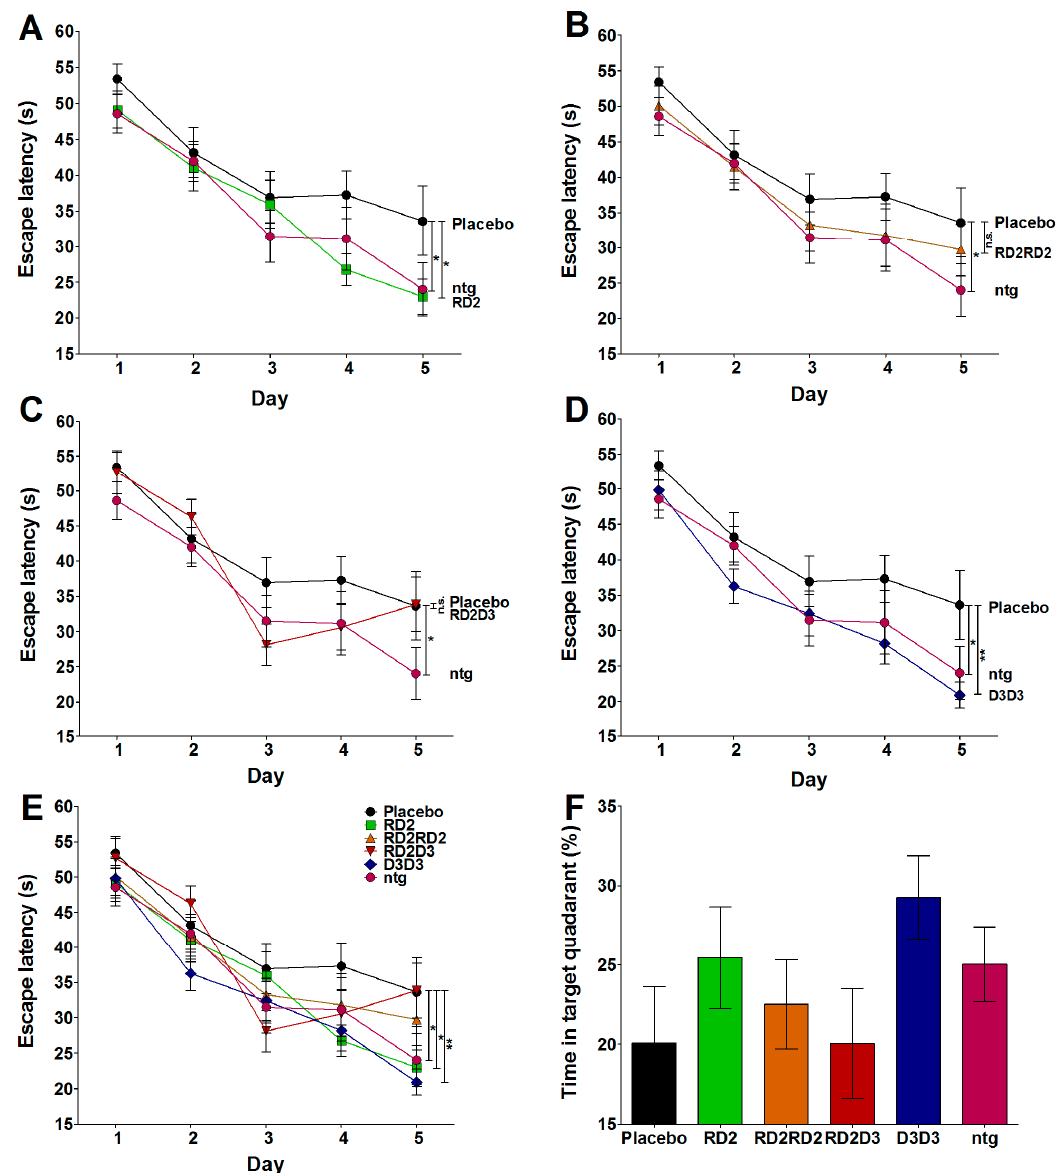
Figure 2. Treatment with RD2 and D3D3 improved cognitive performance as shown in the Morris water maze (MWM). During the acquisition phase of the MWM, RD2- (green, ( A , E )) and D3D3- (blue, ( D , E )) treated mice showed significantly improved learning behaviors compared to those of placebo- (black) treated mice (two-way repeated measurements (RM) ANOVA, Fisher post hoc analysis, * p < 0.05, ** p < 0.001) ( A – C , E ). The improved cognitive performance is indistinguishable to that of non- transgenic littermates (ntg, pink) (( A – C )). Neither RD2RD2- (orange ( B , E )) nor RD2D3- (red, ( C , E